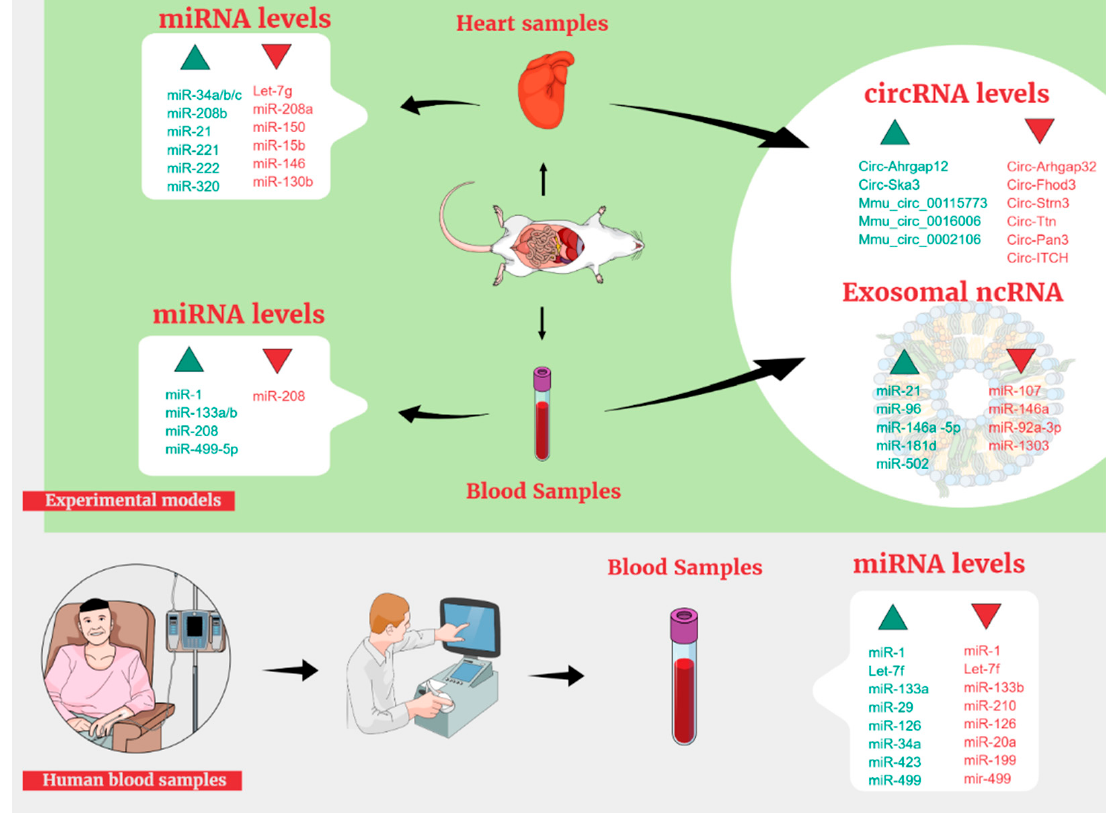
Figure 1. ncRNA and exosomes known as predictors of cardiac damage. Table 1. Studies focused on experimental model heart tissues.